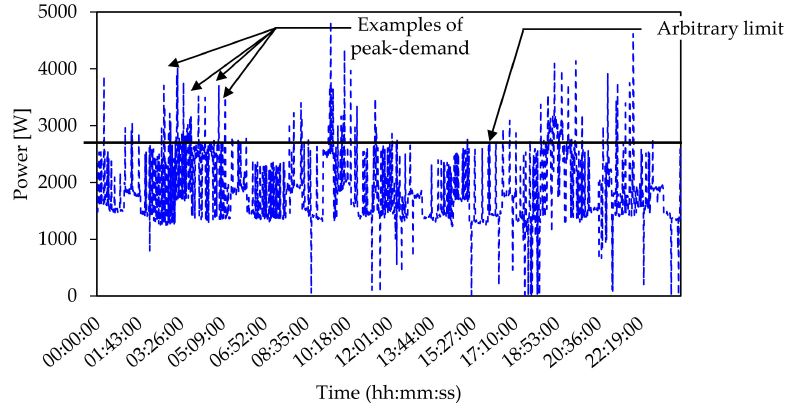
Figure 20. Power demand for the show house No. 1 (3 inhabitants, 130 m 2 , electric heating, sampling period equal to 1